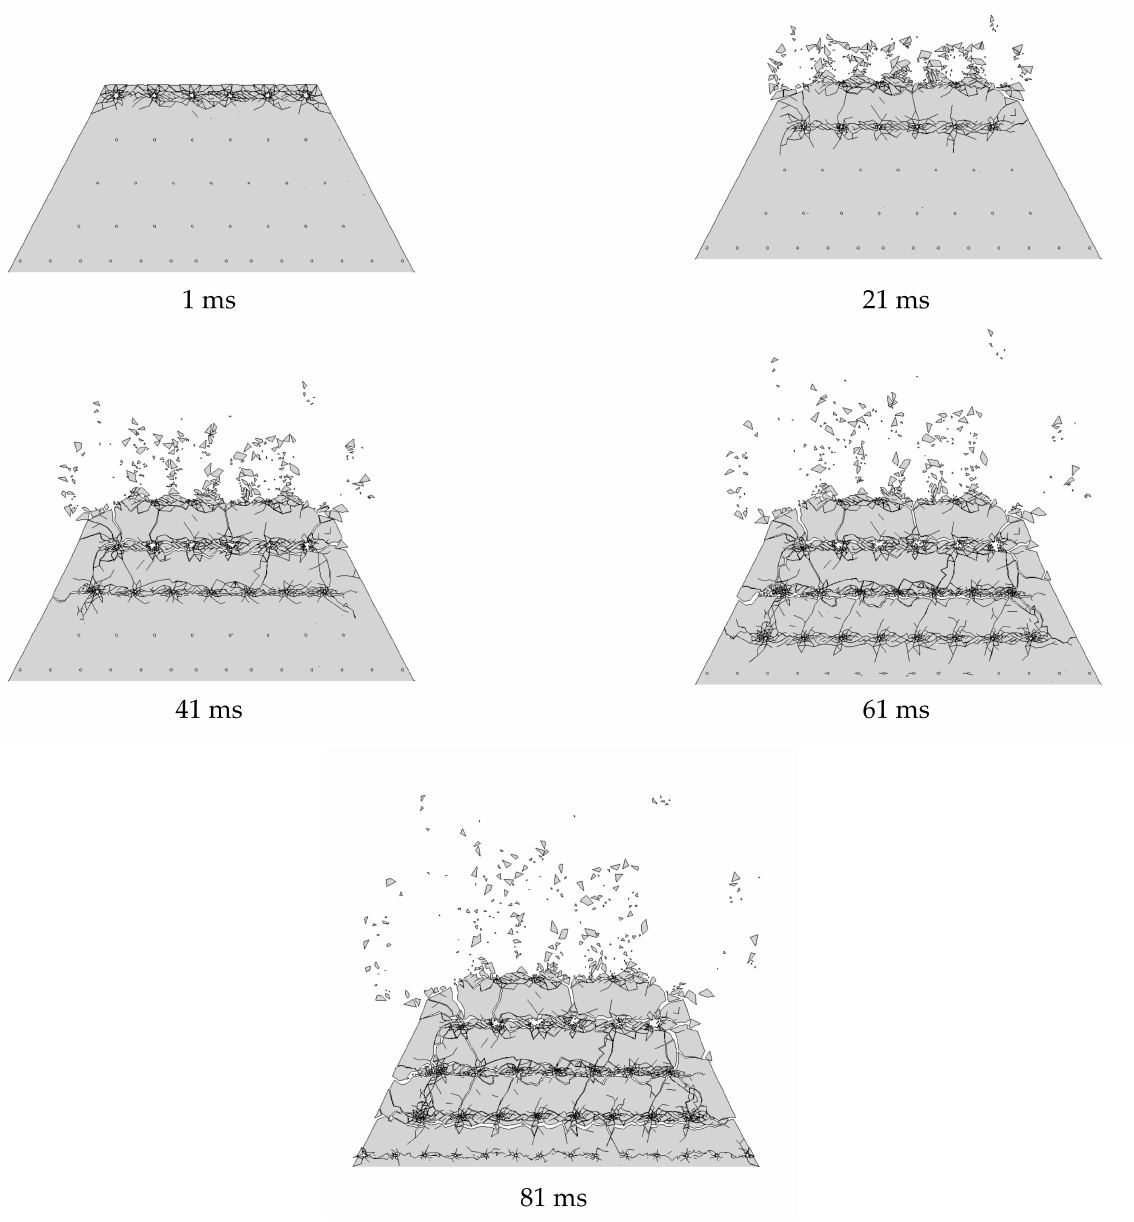
Figure 11. The fracture and fragmentation process of rock using the double side drift